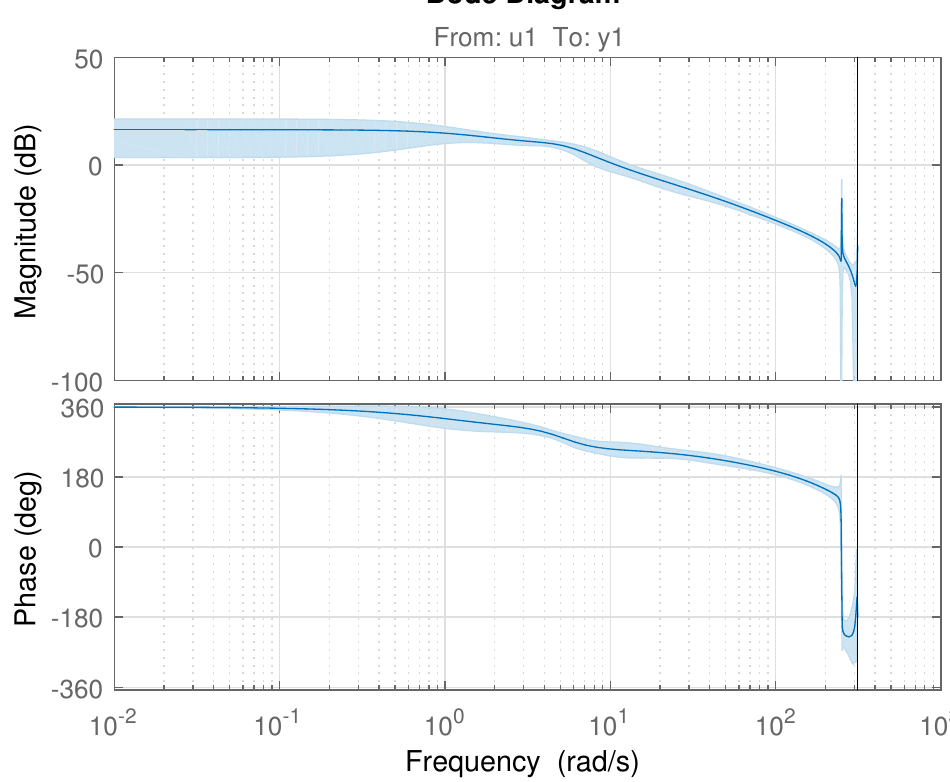
Figure 6. Bode diagram of estimated G ( j ω , θ ) of the Box–Jenkins model. Above is magnitude response. Below is phase